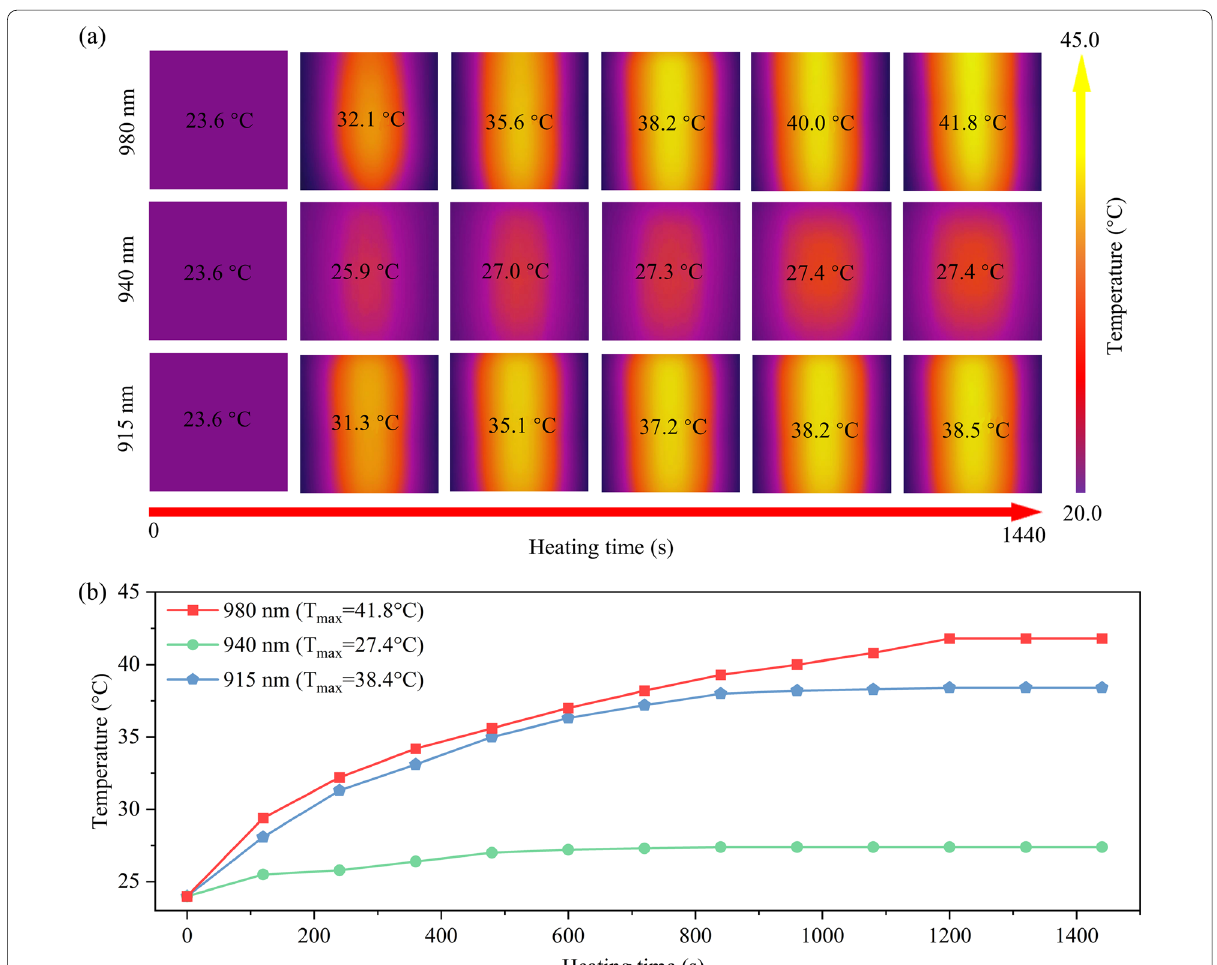
Fig. 5 a The thermal images and b the relationship between temperature and heating time of SrF 2 :Yb 3 + /Ho 3 + (12/0.1 mol%) NCs under the 980, 940 and 915 nm excitations,